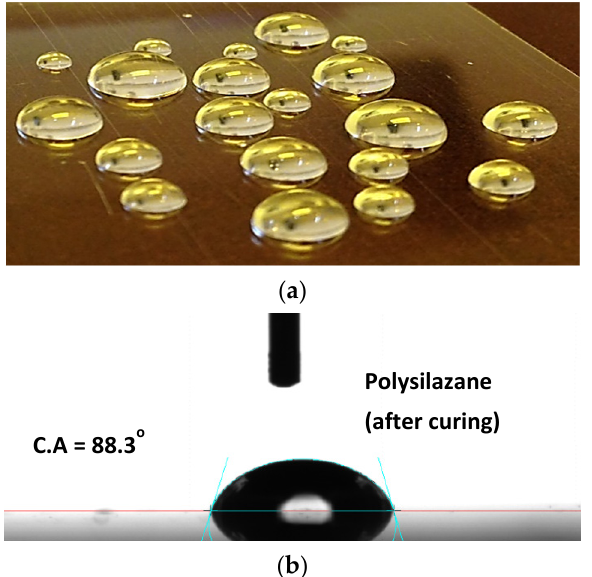
Figure 7. Surface properties of PHPS cured films, ( a ) shows a photo of droplets and their structure on PHPS films coated on PET substrate, and ( b ) shows the exact contact angle measured on water droplet formed on PHPS cured film.